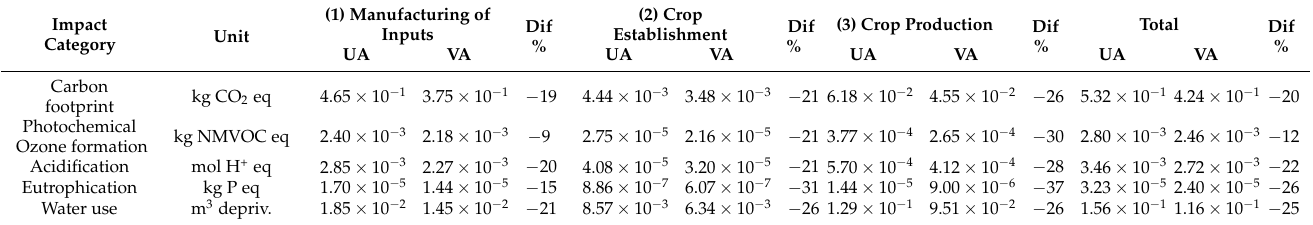
Table 5. Characterized impacts of nectarine production using traditional UA and precision practices VA (per FU = 1 kg of fruit). (Dif %: percentage reduction when comparing UA vs. VA